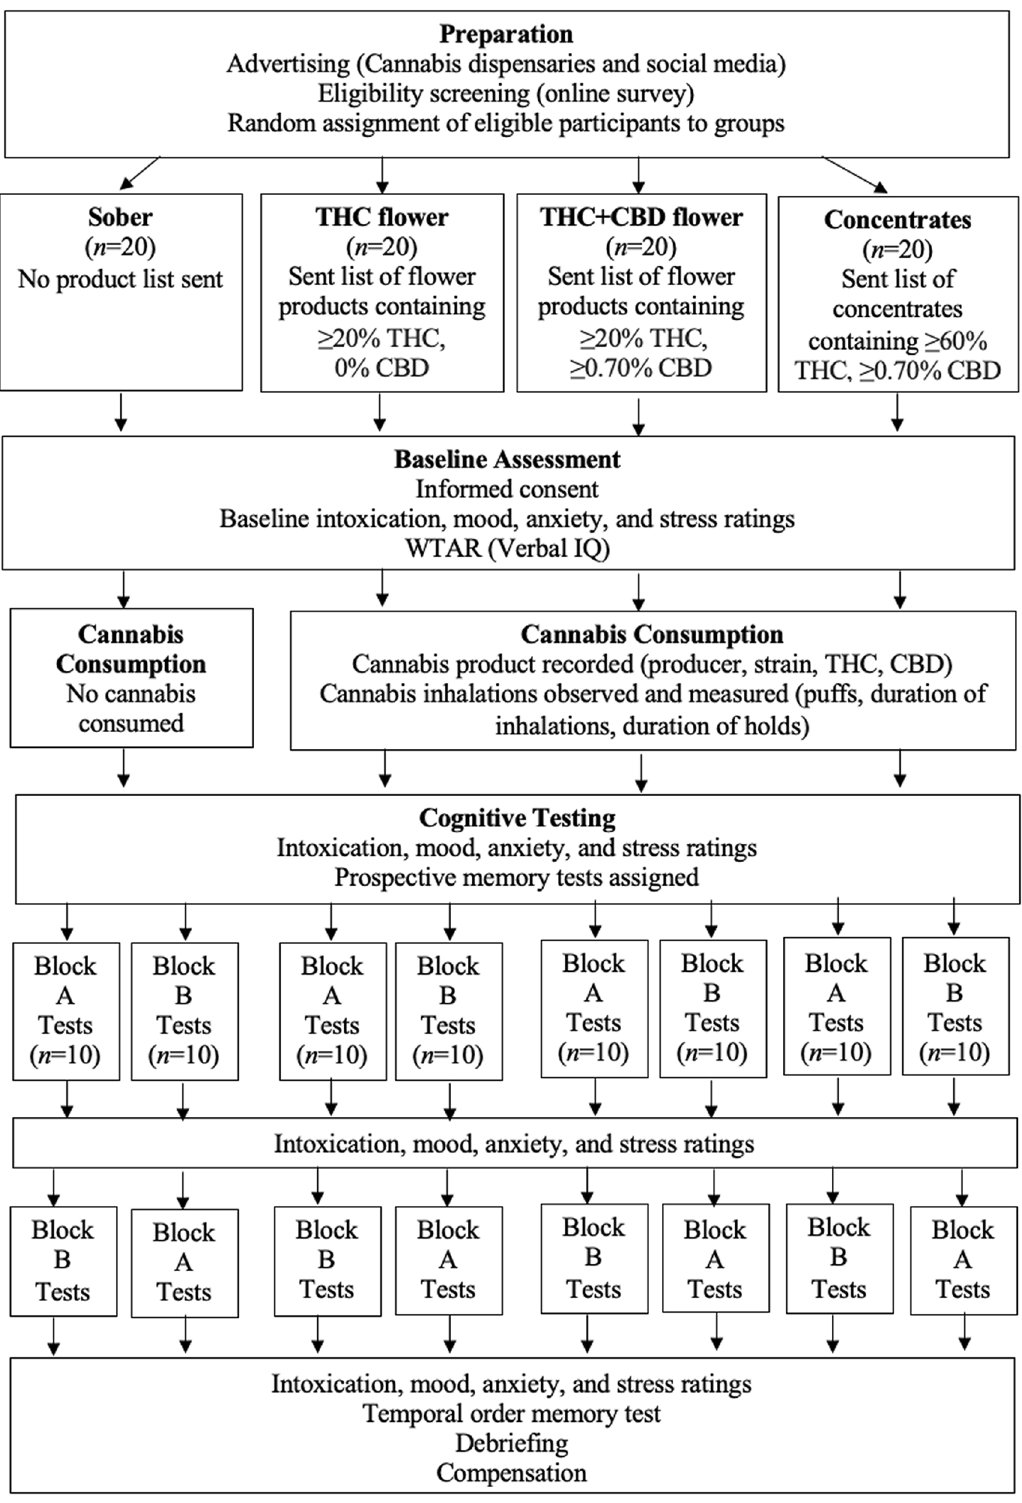
Figure 1. Overview of study procedures. Block A contained the source memory test, the under/overconfidence test of decision making, and the first half of the resistance to framing test (gains framing trials). Block B contained the DRM false memory paradigm, the consistency in risk perception test, and the other half of the resistance to framing test (loss framing trials). Block A and B were completely counterbalanced with 10 participants per group per order in order to control for order effects (e.g., fatigue, strength of drug